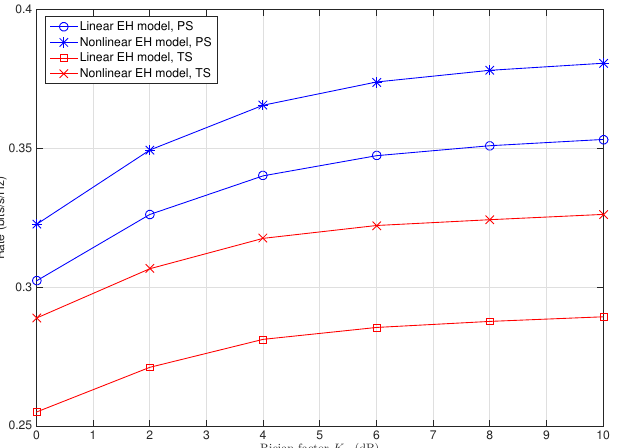
Figure 4. Maximum achievable rate versus the Rician factor K R for SWIPT multi-relay cooperative system with PS and TS schemes when P s / N 0 = 20 dB, β = 2, d sc = 2 m, d cd = 4